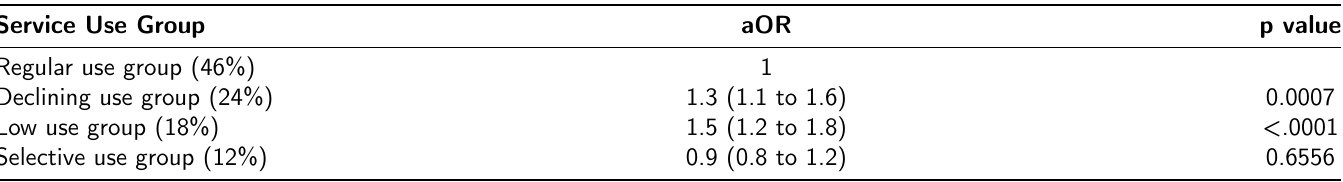
Table 3: Associations between service use group membership and developmental vulnerability (DV1), adjusted for cumulative risks 1